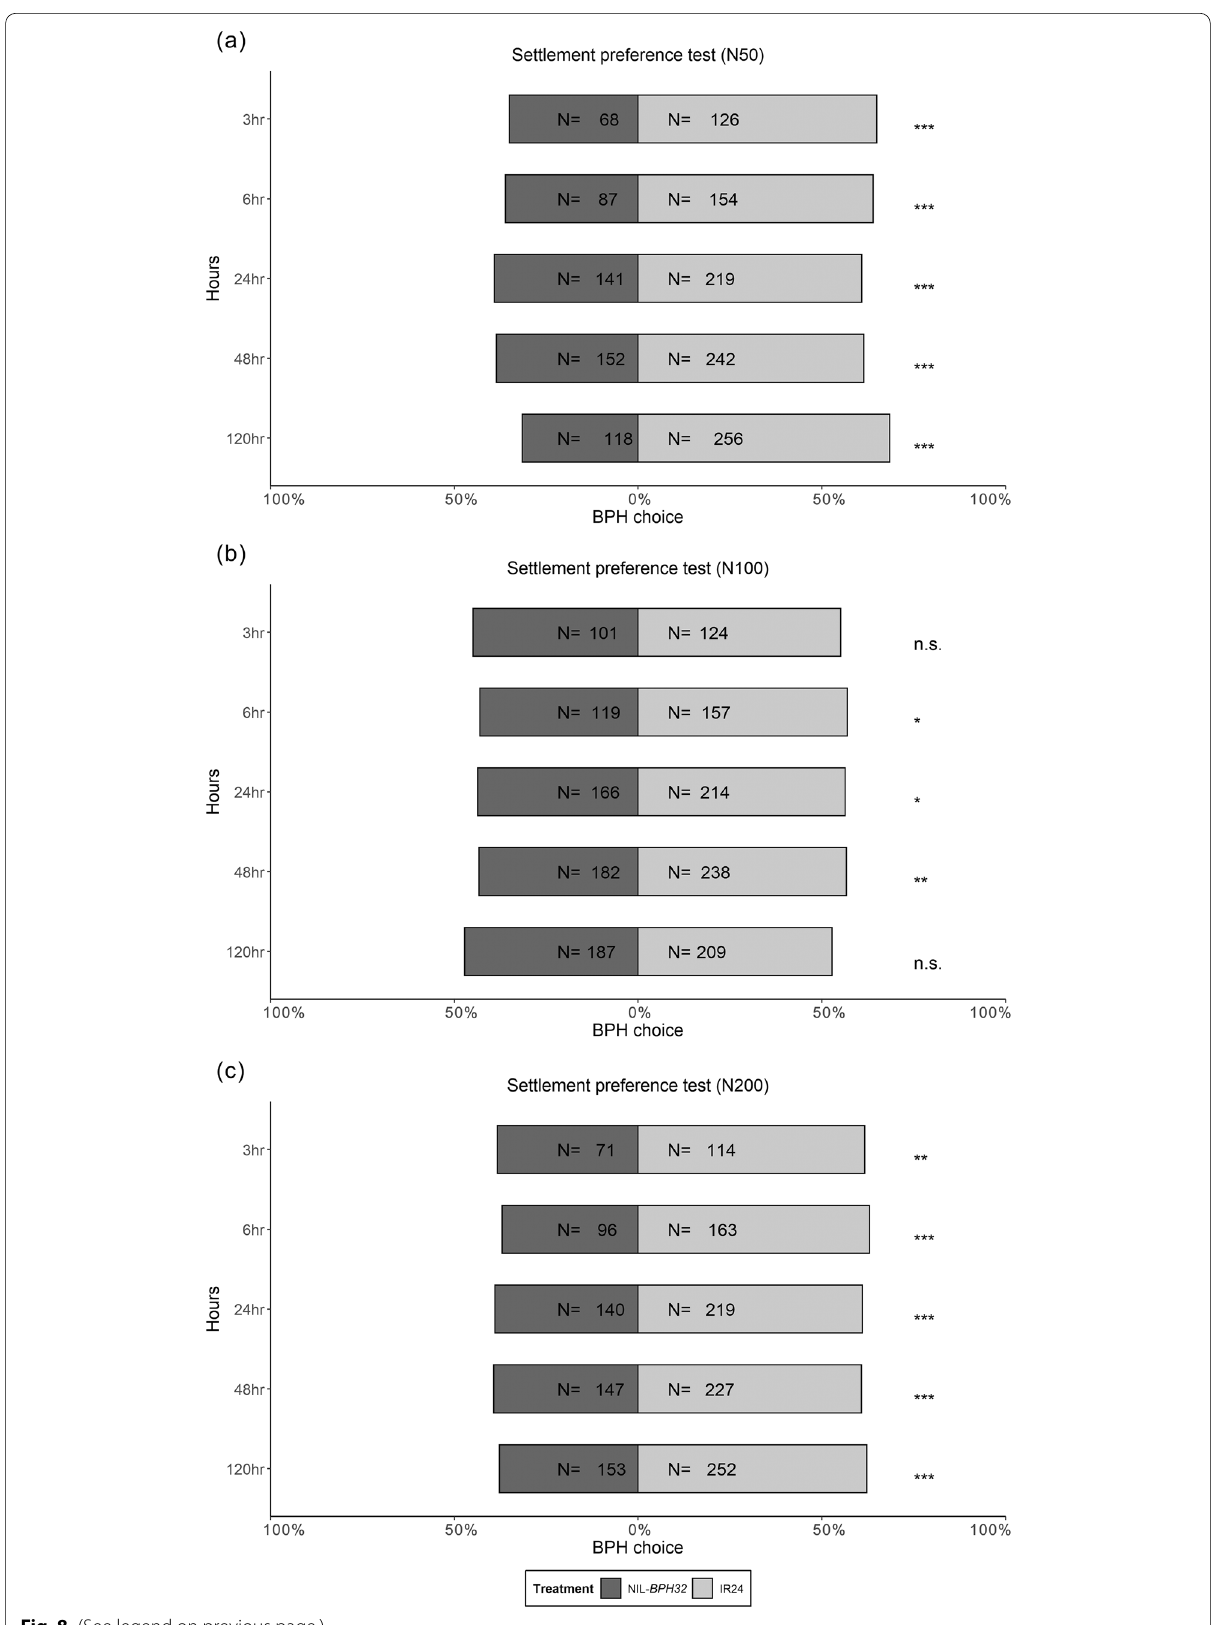
Fig. 8 (See legend on previous